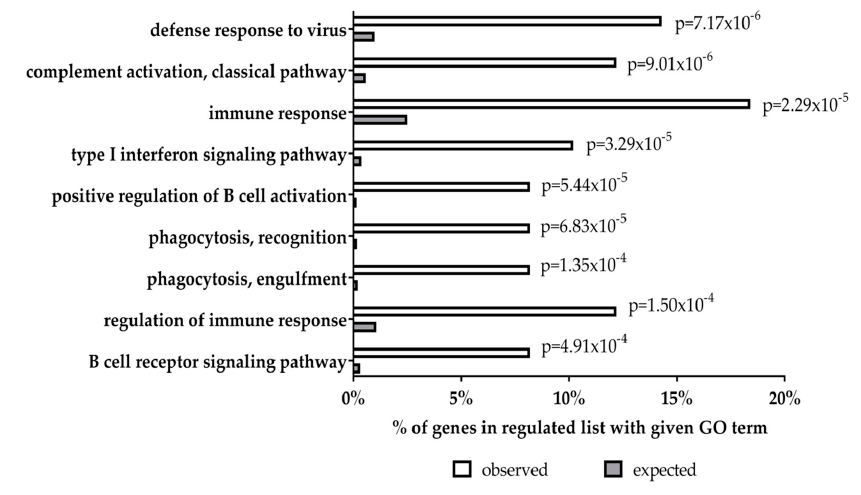
Figure 3. GO analysis of genes downregulated by both LMP1 and LMP2A in GC B cells. Gene lists were derived from our reanalysis of genes differentially expressed in either LMP1 or LMP2A expressing GC B cells. Gene set enrichment was performed using DAVID 6.8 [99,100].